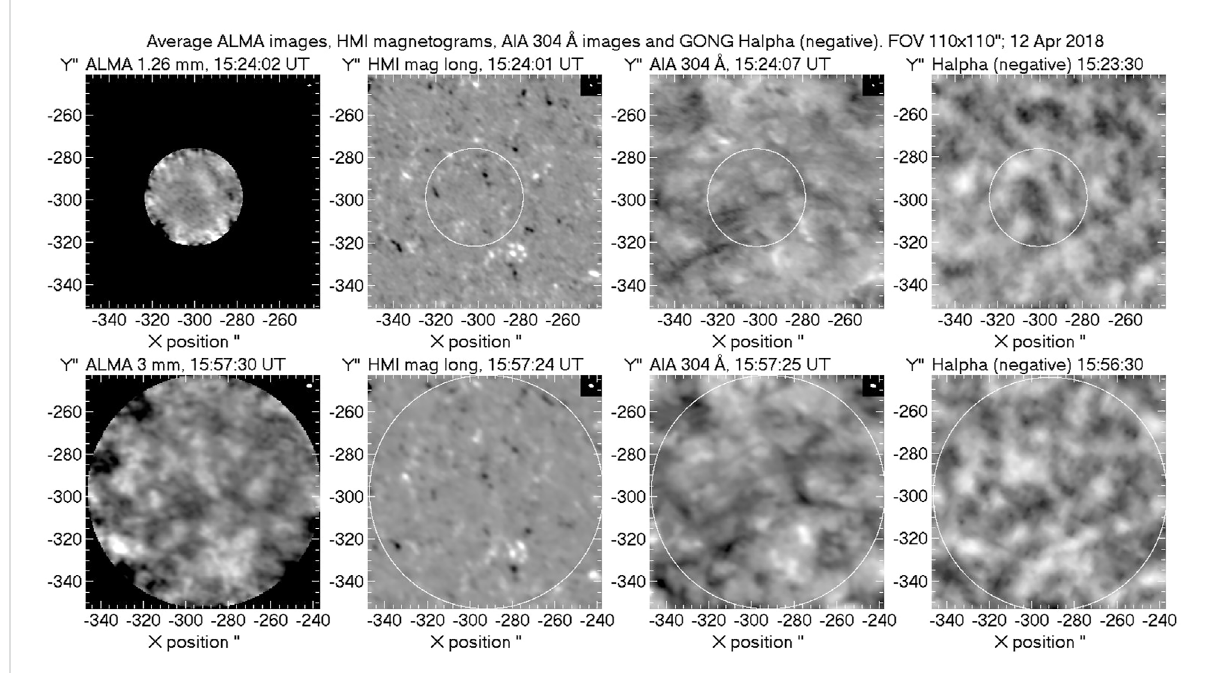
FIGURE 12 Average ALMA images of the network in Band 6 (top-left) and in Band 3 (bottom-left), together with the corresponding HMI magnetograms (saturated at ± 50 G), as well as AIA 304 Å and H α negative images from GONG. The insert at the top right corner of the images shows the ALMA resolution.Thecirclesinthenon-ALMAimagesmarktheALMA fi eldofview.Allimagesareorientedwiththecelestialnorthpointingup(fromNindos et al., 2021, reproduced with permission ⓒ ESO).